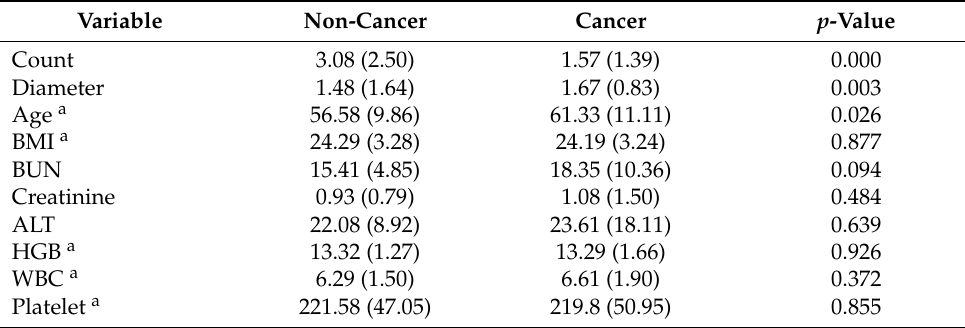
Table 3. The mean (standard deviation) of the continuous variables in the cancer and non-cancer groups, and the p -values of testing the significance of the variables. Age, nodule count, and diameter were found to be significant to lung cancer with p -values less than 0.05.